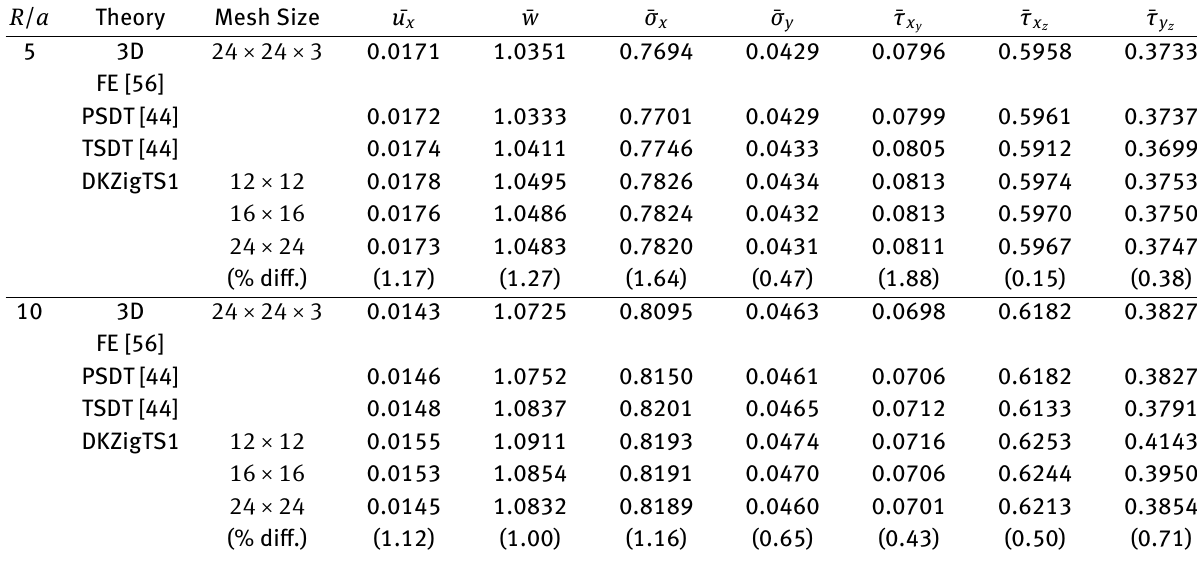
Table 13: Non-dimensionalised central deflection and stresses for an all-round simply supported composite spherical shell panel ‘A’ with b / a = 1 , h / a = 0.1 under uniformly distributed load